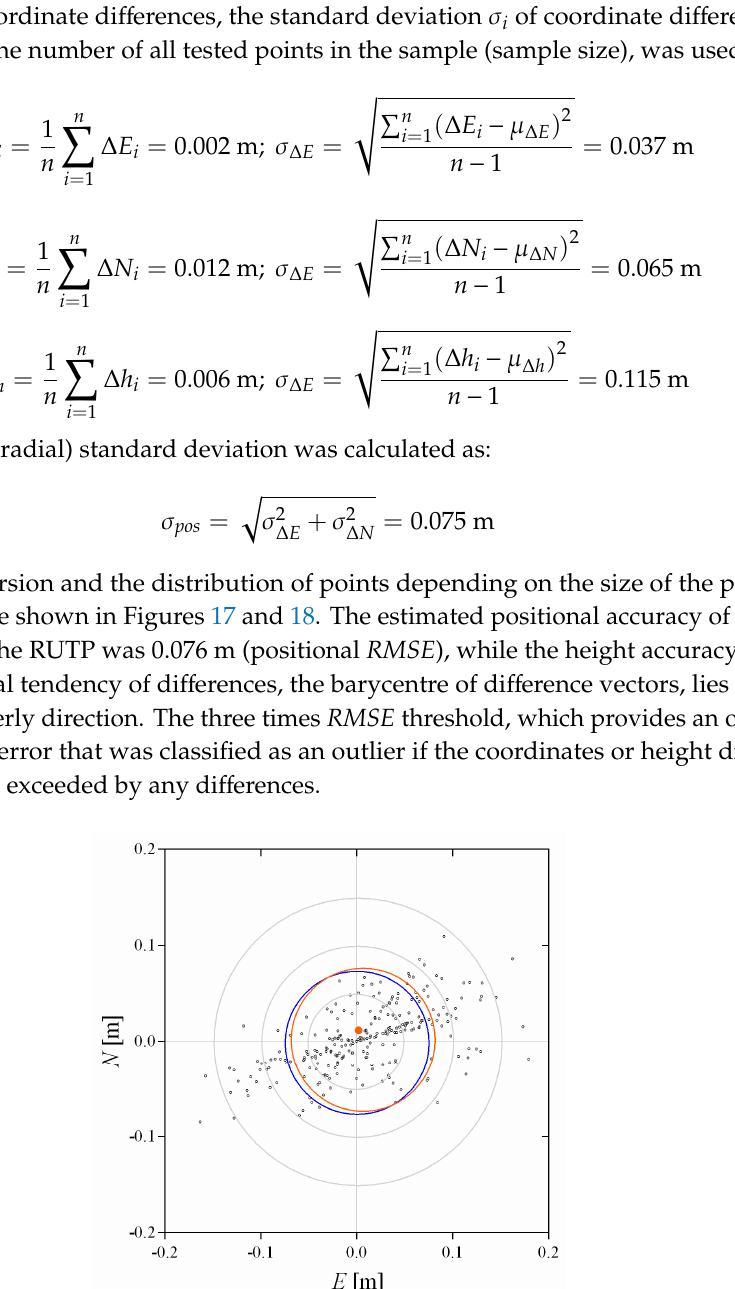
Figure 17. Presentation of the position differences of apex points of UUI in real urban testing pools: circles (grey colour) indicating the position differences 5 cm, 10 cm and 15 cm; 0.076 m: position root mean square error ( RMSE ) (blue circle), 0.075 cm: position σ pos (red circle) and the barycentre of difference vectors (red point).